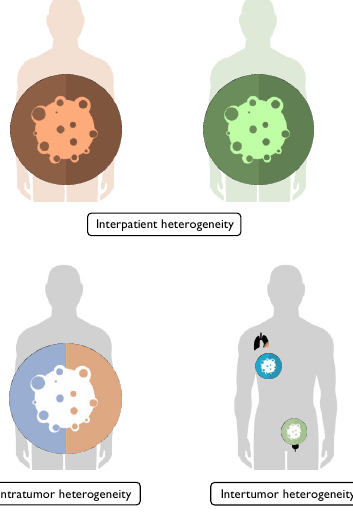
Figure 1. Different types of bladder cancer heterogeneity (see text).